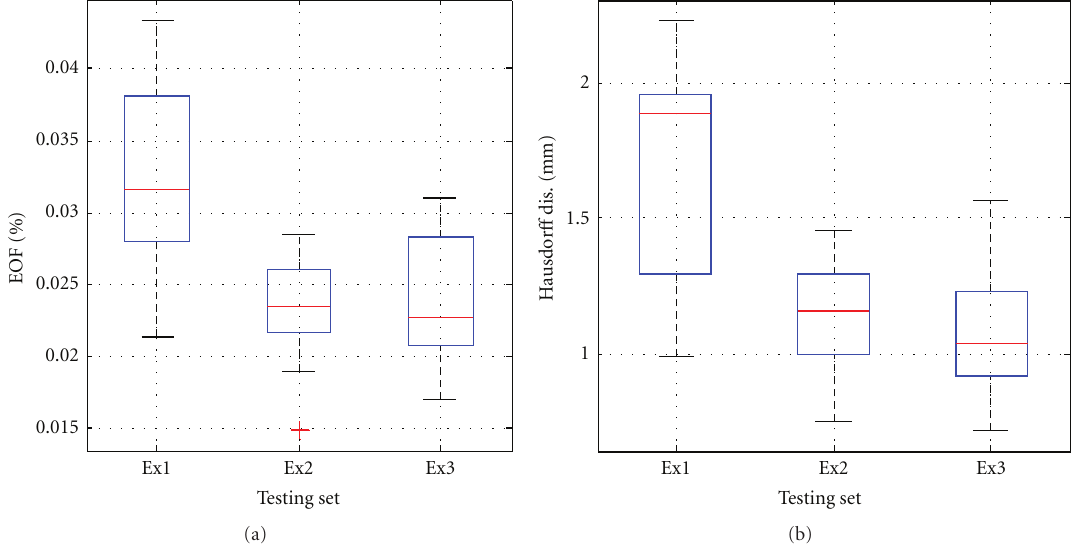
Figure 22: Boxplots of representation error in LV interpatient experiments: (a) EOF, (b) Hausdor ff